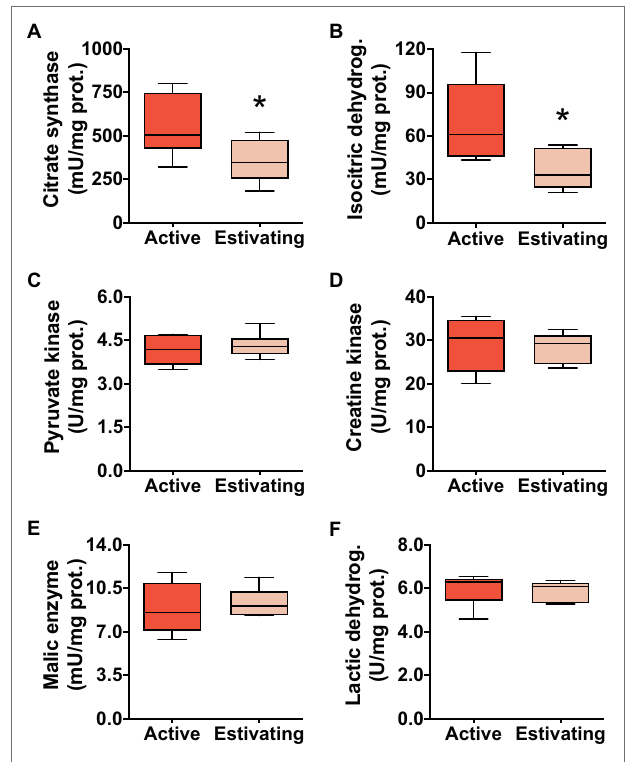
FIGURE 2 | Activities of enzymes that catalyze key steps in metabolic pathways in the skeletal muscle of Pleurodema diplolister collected during the dry season (estivating) or the rainy season (active). (A) Citrate synthase. (B) Isocitric dehydrogenase. (C) Pyruvate kinase. (D) Creatine